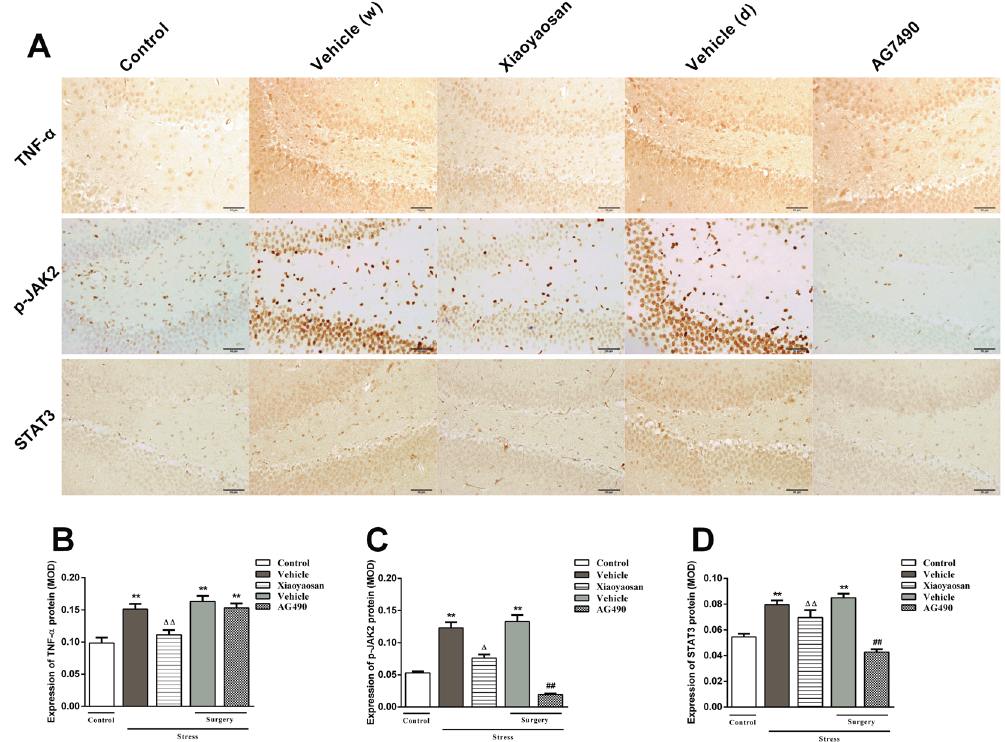
Figure 3. Effects of Xiaoyaosan on the expression of the TNF- α , p-JAK2 and STAT3 proteins in the rat hippocampus. ( A ) Representative micrographs of immunohistochemical staining for the TNF- α , p-JAK2 and STAT3 proteins (scale bar = 50 μ m, 400 × magnification) in the hippocampal DG region. ( B ) Quantitative analysis of the TNF- α protein levels. ( C ) Quantitative analysis of the p-JAK2 protein levels. ( D ) Quantitative analysis of the STAT3 protein levels. Values are presented as the means ± SEM from 5 rats in each group. ** P < 0.01 versus the control group. Δ P < 0.05 or ΔΔ P < 0.01 versus the vehicle (distilled water) group. ## P < 0.01 versus the vehicle (dissolvent) group.